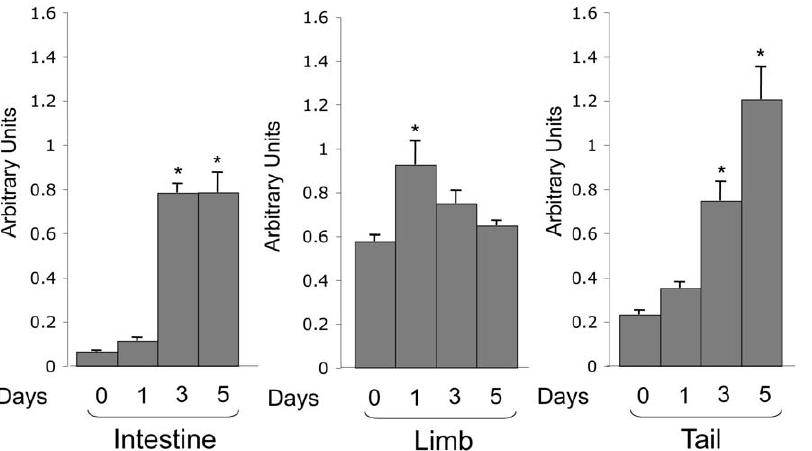
Figure 6. T3-inducktion of TIMP2 expression in different tissues of premetamorphic tadpoles. Tadpoles at premetamorphic stage 54 were treated with 10 nM T3 at 18 u C and collected every other day for isolating total RNA from different tissues. The RNA was analyzed by qRT-PCR analysis as in Fig. 5. *: p , 0.05 when compared to the group without T3 treatment.